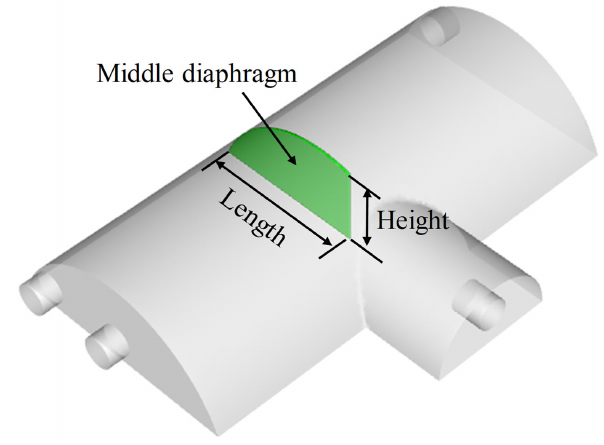
Figure 12. The middle diaphragm of the air cabin.